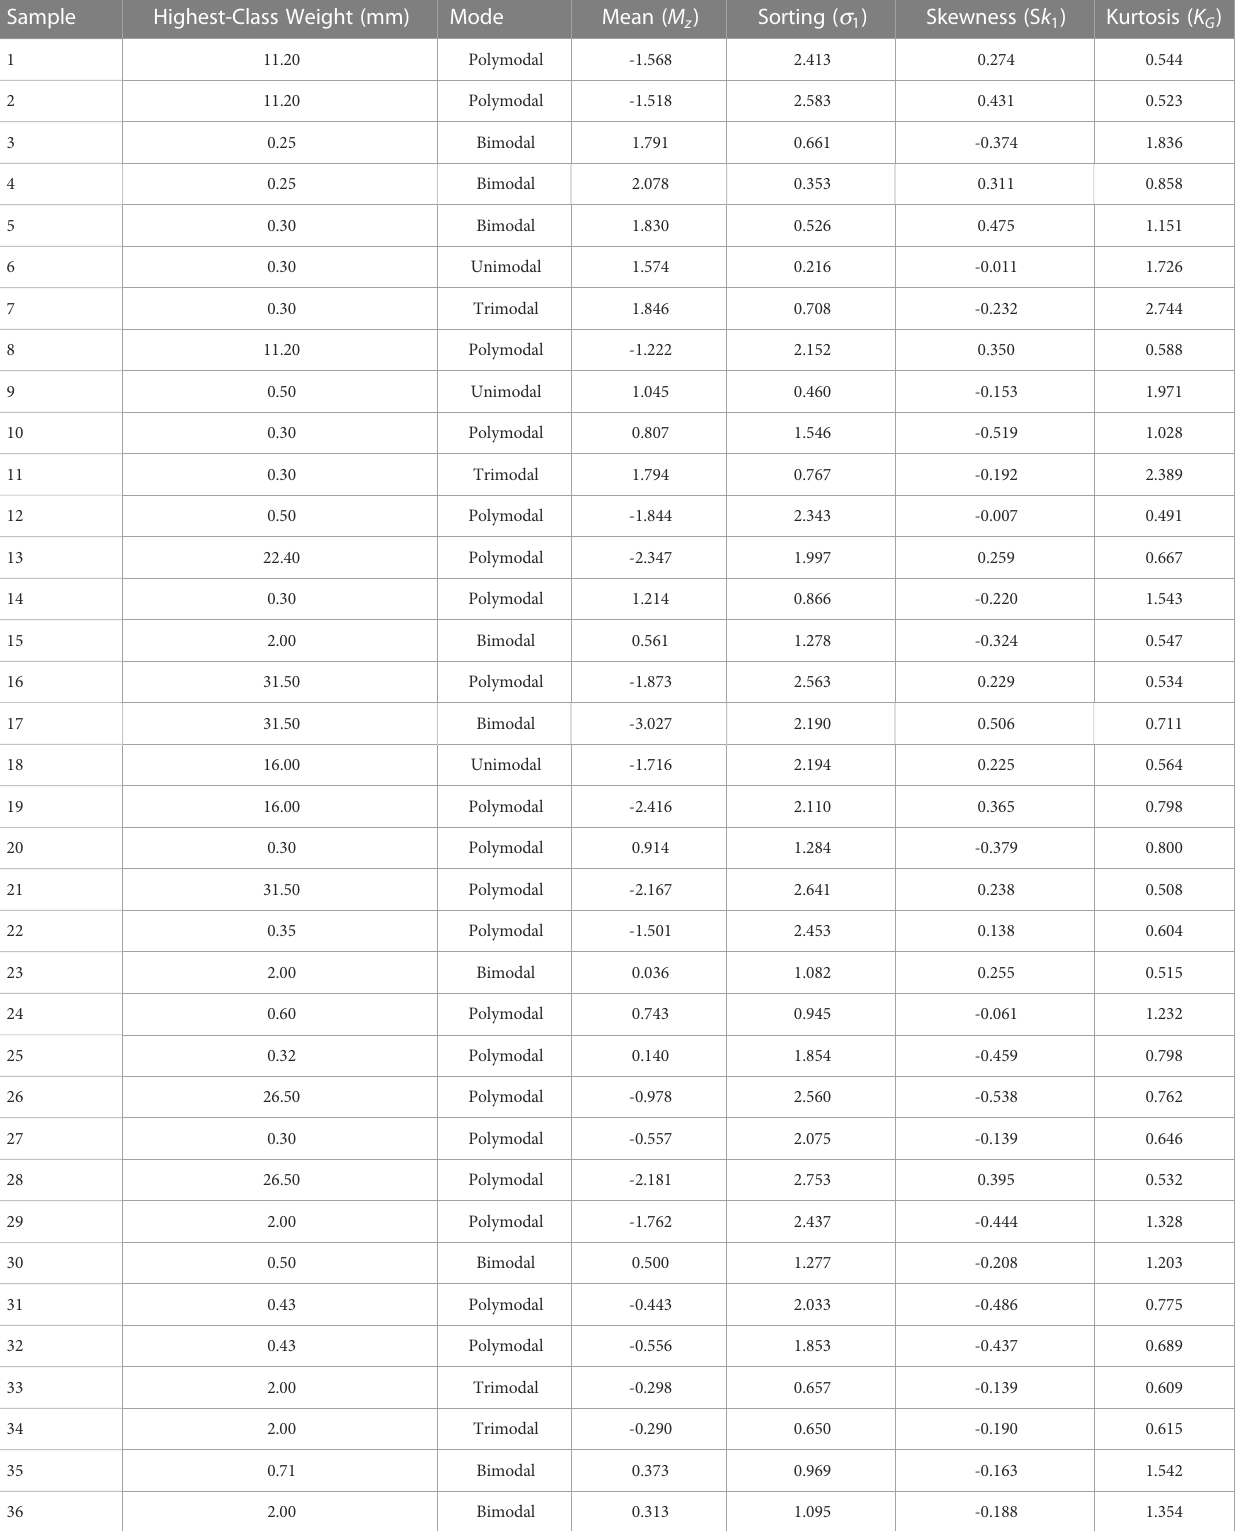
TABLE 2 Parameters for describing grain size